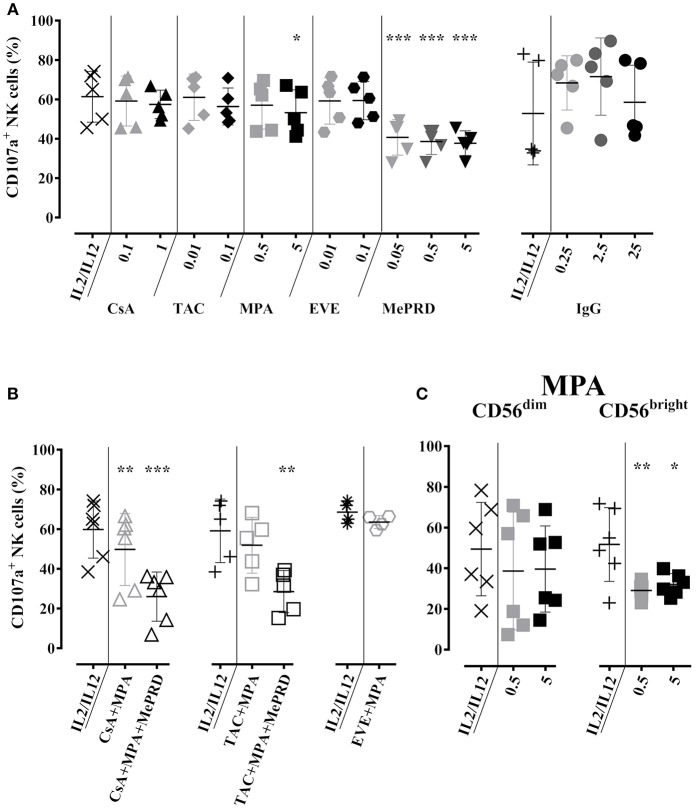
Partial inhibition of NK cell degranulation by MePRD and differential effect of MPA on CD56dim and CD56bright NK cell subpopulations. Purified NK cells were incubated overnight with IL2 (50 U/ml) and IL12 (0.5 ng/ml) in the presence or absence of CsA (0.1–1 μg/ml), TAC (0.01–0.1 μg/ml), MPA (0.5–5 μg/ml), EVE (0.01–0.1 μg/ml), MePRD (0.05–5 μg/ml) IVIg (0.25–25 mg/ml). Data for ISD/IVIg alone (A), and ISD combinations (B) are shown. When used combined, the following concentrations were used: CsA (0.1 μg/ml); TAC (0.01 μg/ml); MPA (5 μg/ml); EVE (0.01 μg/ml), and MePRD (0.5 μg/ml). The specific effect of MPA on CD56dim and CD56bright NK subpopulations is shown in (C). Carrier solutions containing ethanol (EtOH) or vehicle in the case of IVIg were used as internal controls (not shown). Degranulation was measured by detecting CD107a up-regulation on the surface of NK cells upon incubation with K562 cells for 3h at an effector to stimulator (E:S) ratio of 1:1. Golgistop was added 2h prior the end of the incubation, followed by CD56 staining and flow cytometry analysis. Data are presented as percentage of CD56+CD107+ cells ± SD. Symbols represent individual experiments, (A)
n = 5 for ISD, n = 4 for IVIG; (B)
n = 5; and (C)
n = 6. Statistical analysis was performed using one-way ANOVA for matched data with Dunnett's Multiple Comparison Test as post-test vs. IL2/IL12 with the exception of EVE/MPA (B) were paired t-test was performed.*p < 0.05, **p < 0.01, ***p < 0.005.